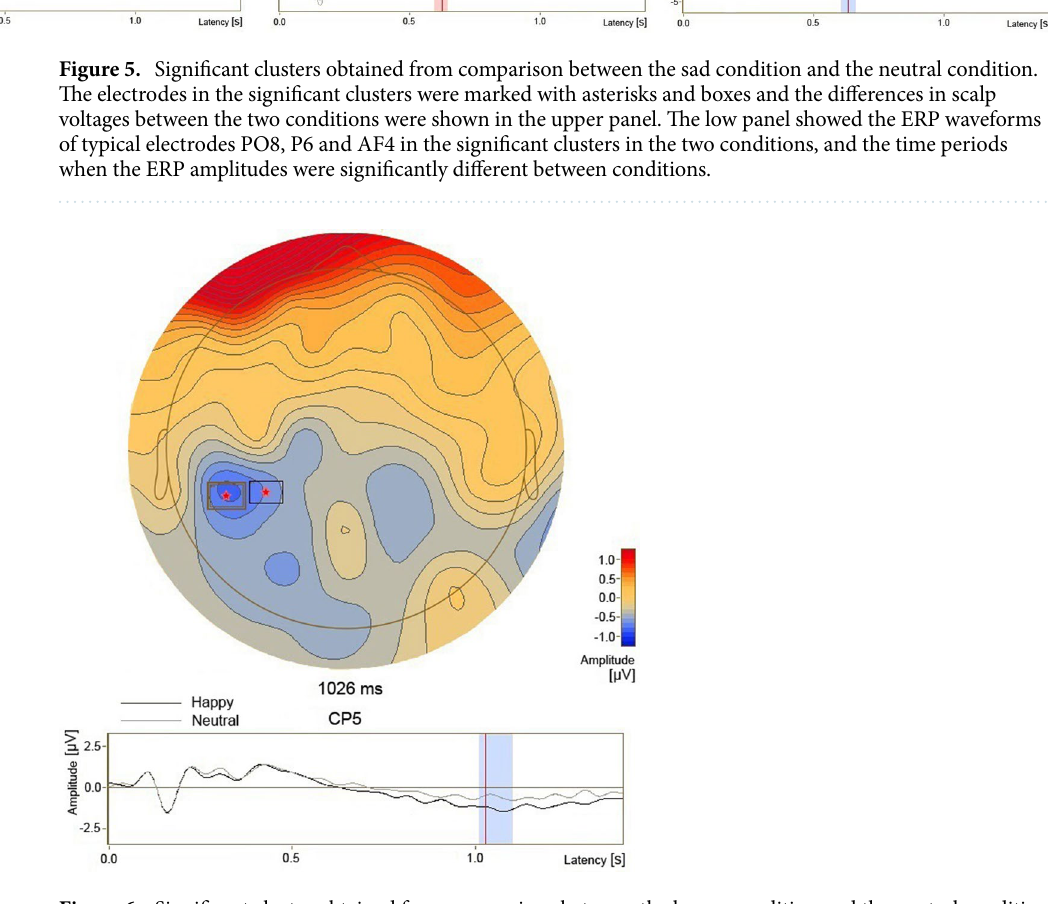
Figure 6. Significant cluster obtained from comparison between the happy condition and the neutral condition. The electrodes in the significant cluster were marked with asterisks and boxes and the differences in scalp voltages between the two conditions were shown in the upper panel. The low panel showed the ERP waveforms of typical electrode CP5 in the significant cluster in the two conditions, and the time period when the ERP amplitudes were significantly different between